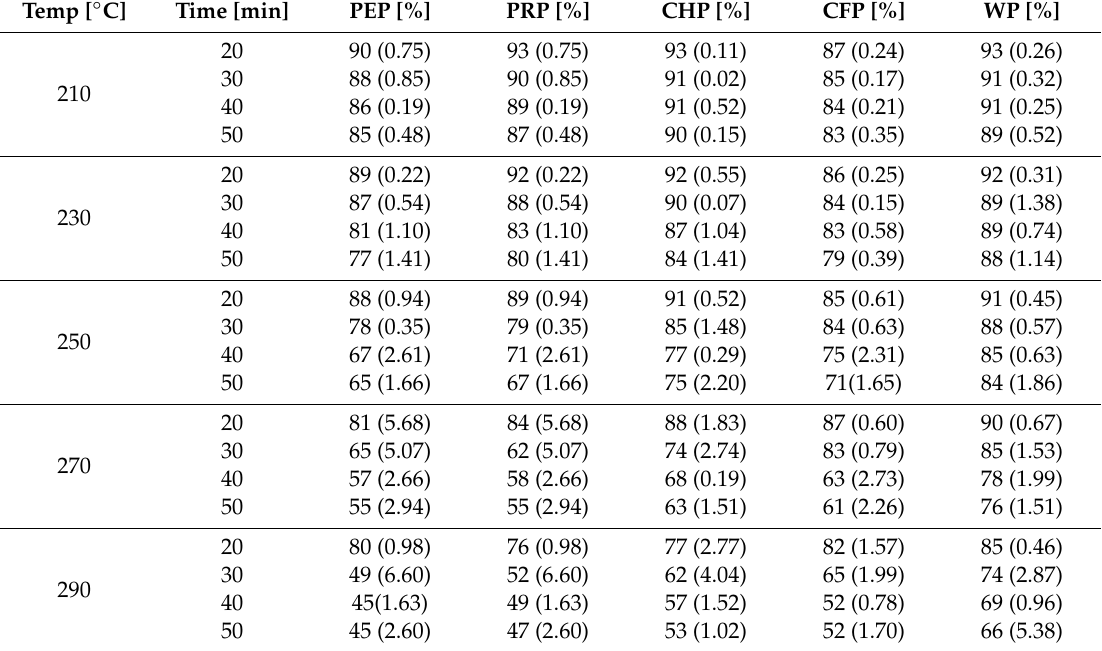
Table 2. Mass yield of torrefied